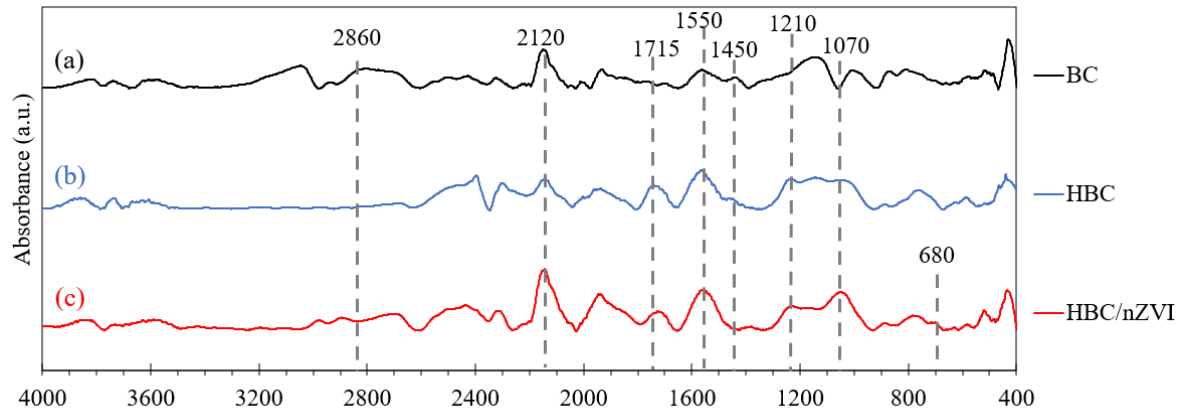
Figure 3. FTIR spectra of BC, HBC, and HBC/nZVI (before contact with the Cr(VI)